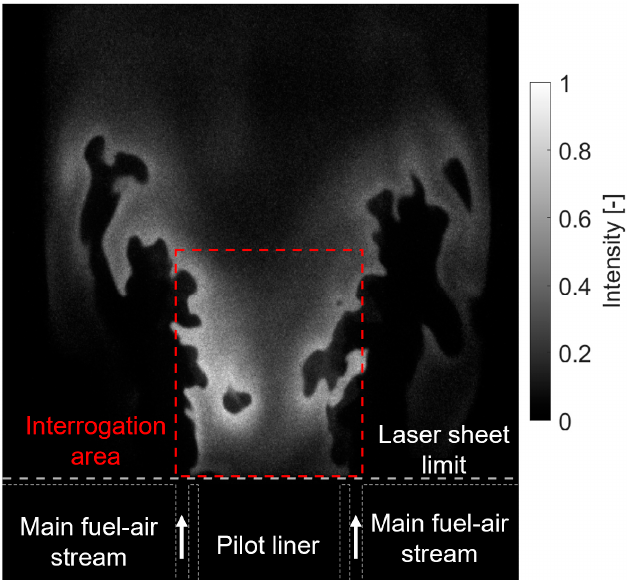
Figure 3. An example of a single-shot OH-PLIF image with the interrogation area shown as a red dashed rectangle.